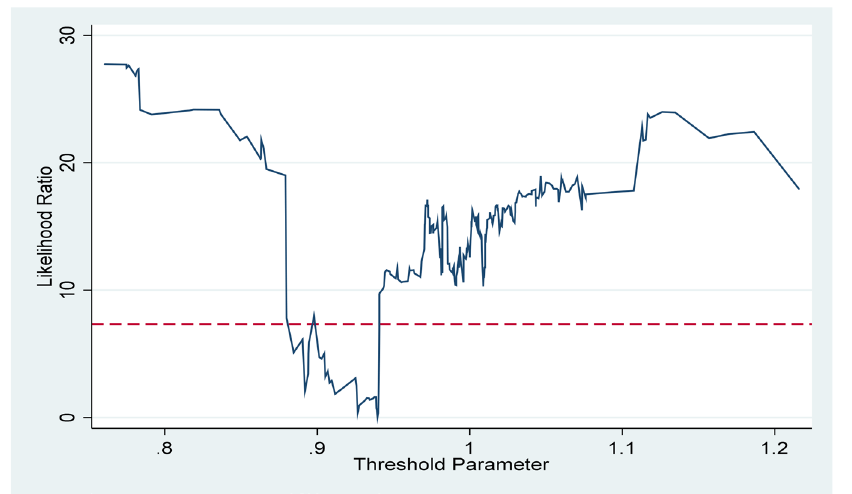
Figure 7. Threshold